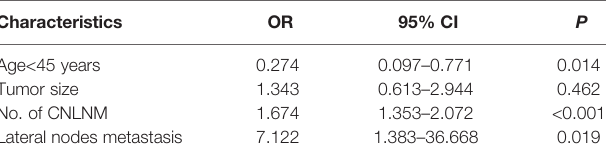
TABLE 2 | Multivariable analysis of RLNIZ lymph node metastasis in patients with primary surgery for PTC.